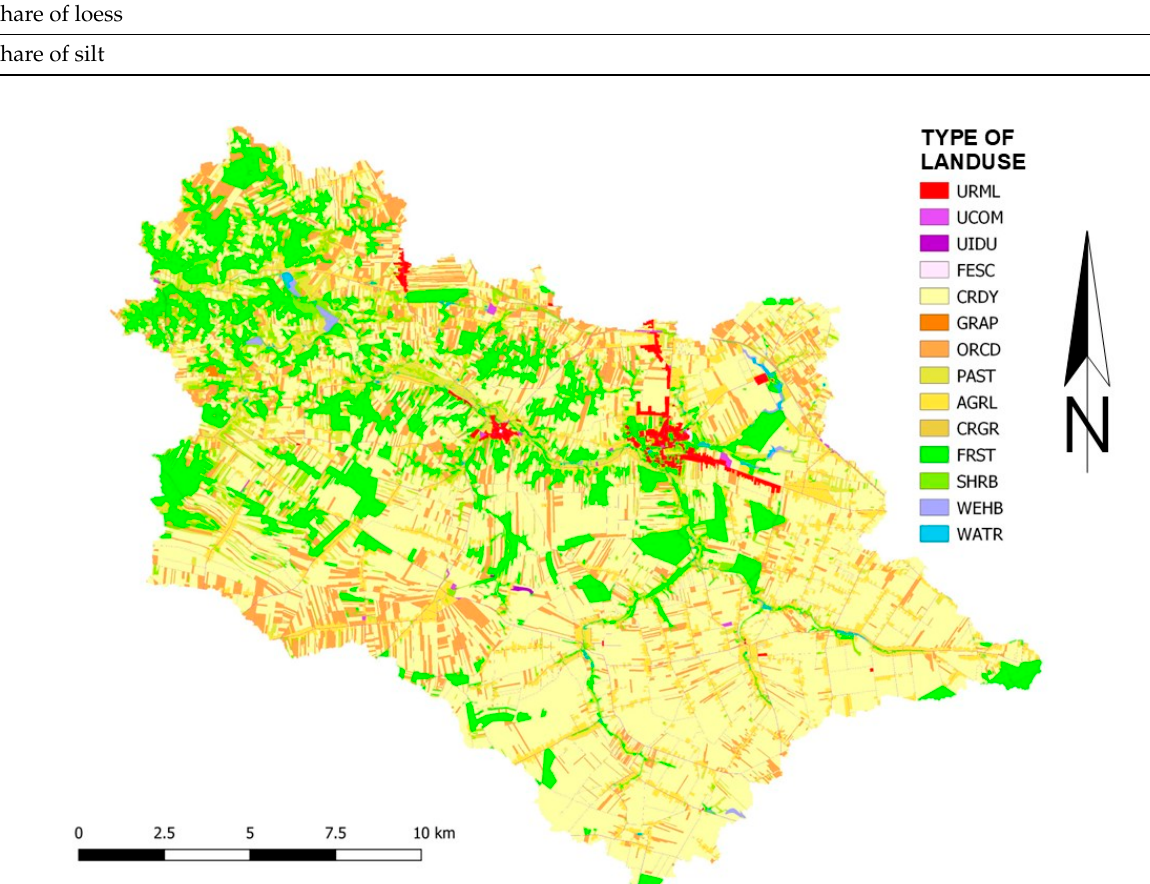
Figure 4. Land cover and use map of Bystra basin (own study). The largest part of agricultural land is arable land beyond the range of irrigation fa- cilities (52%), a large area is also orchards and plantations (11%), complex systems of cultivating plots (9%) and meadows and pastures (6%) (Table 2). Table 2. Division of the cover and use as well as the percentage of use in the Bystra basin generated in the QSWAT interface (own study). Corine Land Cover Legend